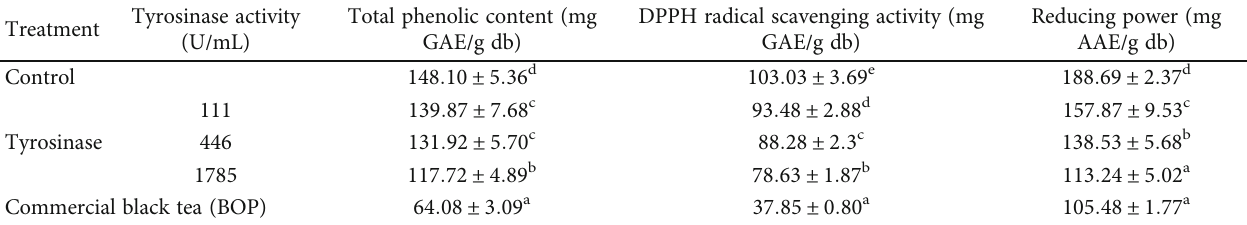
Table 3: Antioxidant activity and total phenolic content of tea leaf extract treated with tyrosinase. Treatment